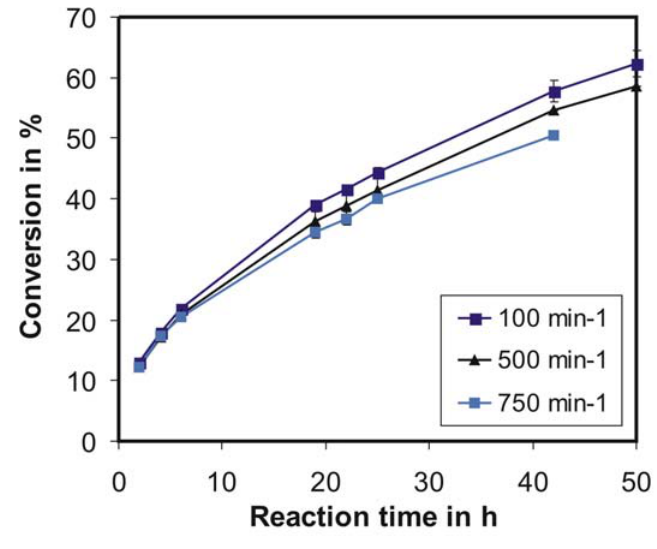
Figure 7. Cellulose conversion during parallel continuous operations for different stirrer = 1120 U/L, c = 25 g/L, τ = 6 h, T = 40 °C, pH = speeds. c E S,0